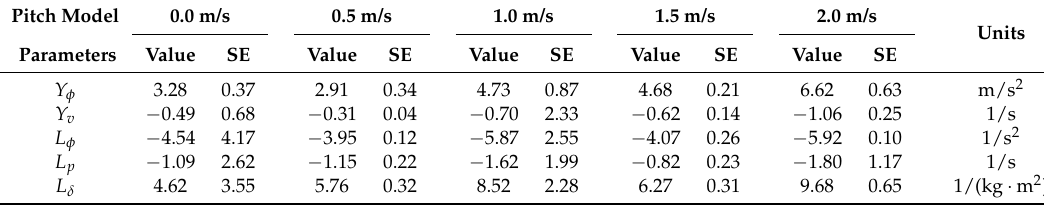
Table 5. Nominal roll model parameter